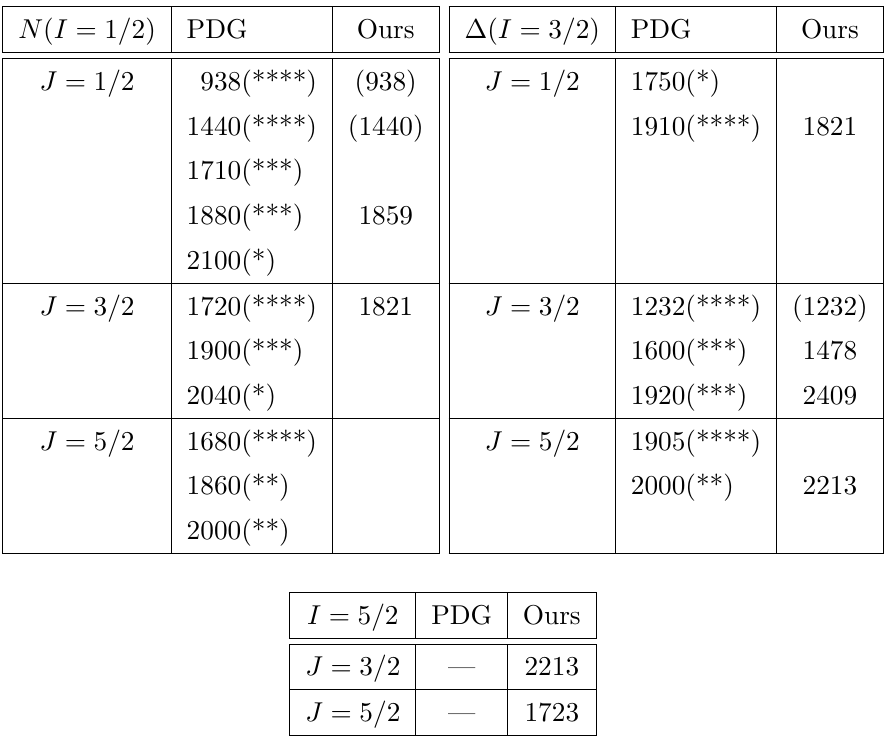
Table 10 . Our results for the baryon resonance. Numbers in the parenthesis ( (cid:1) ) in our results are used to (cid:12)t and trivially agrees with the experimental data [81]. The number of (cid:3) denotes the experimental observation